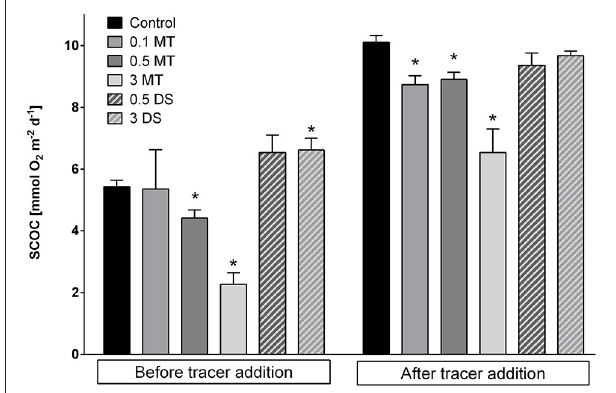
FIGURE 5 | Biomass per depth and treatment in the three biological compartments measured: Bacteria (left y-axis), macrofauna and Nematoda (right y-axis). Error bars depict standard errors and point downwards for the 2–5 cm and 5–10 cm data for better visualization. Abbreviations: 0.1 MT = 0.1cm mine tailing addition, 0.5 MT = 0.5 cm mine tailing addition, 3 MT = 3 cm mine tailing addition, 0.5 DS = 0.5cm dead sediment addition, 3 DS = 3 cm dead sediment addition.